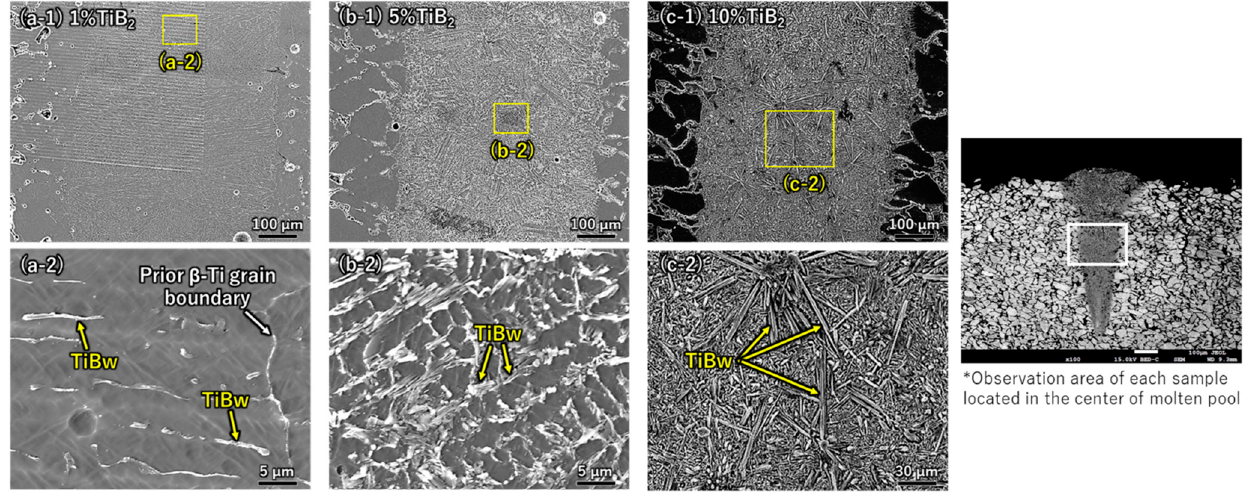
Figure 10. SEM images of the center of the molten pools on Ti64- ( a ) 1, ( b ) 5, and ( c ) 10 mass% TiB 2 pre-mixed powder compacts ((-1) low magnification and (-2) high magnification).